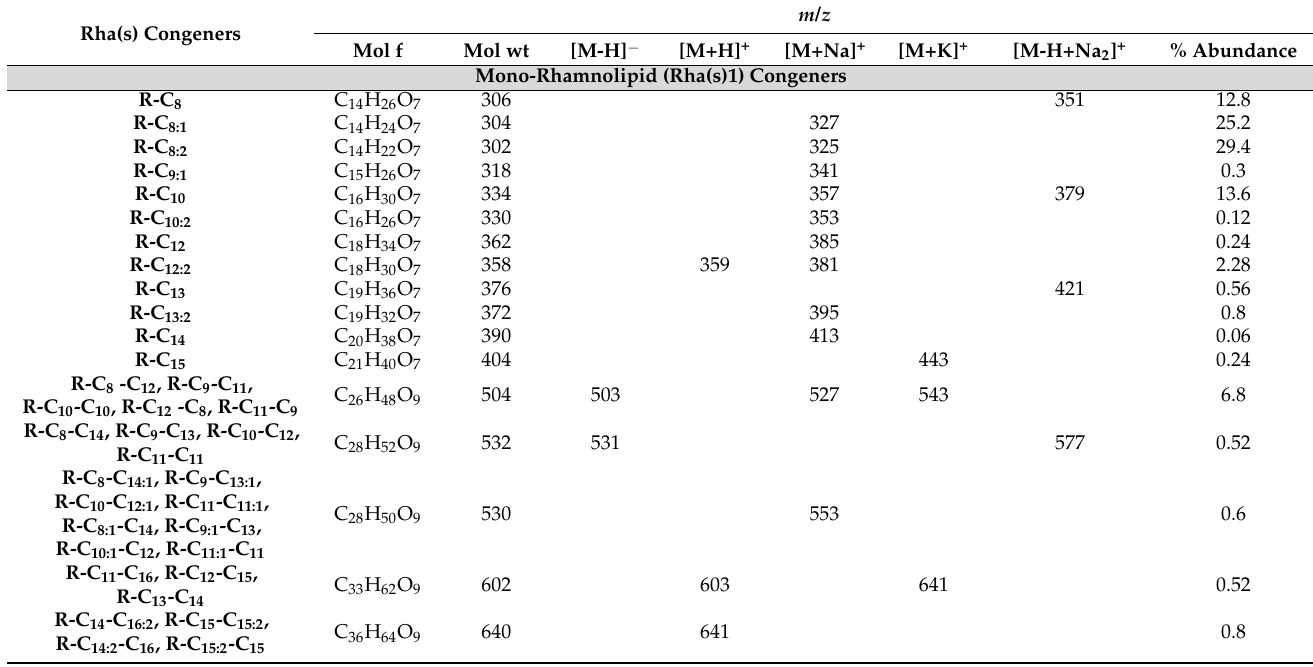
Table 1. Congeners composition of rhamnolipids mixture produced by P. aeruginosa strain LeS3 as analyzed by LC/ESI-MS at both positive and negative